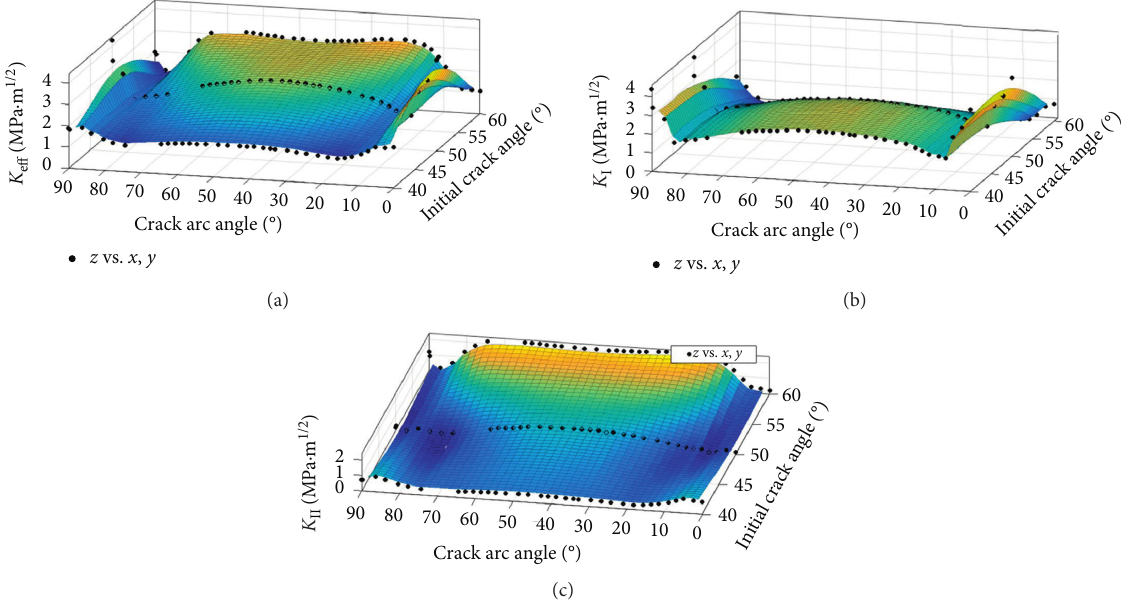
Figure 17: Calculation of the SIFs of crack I: (a) the calculation result of K eff for the crack I at different initial crack angles; (b) the calculation result of K I for the crack I at different initial crack angles; (c) the calculation result of K II for the crack I at different initial crack angles.